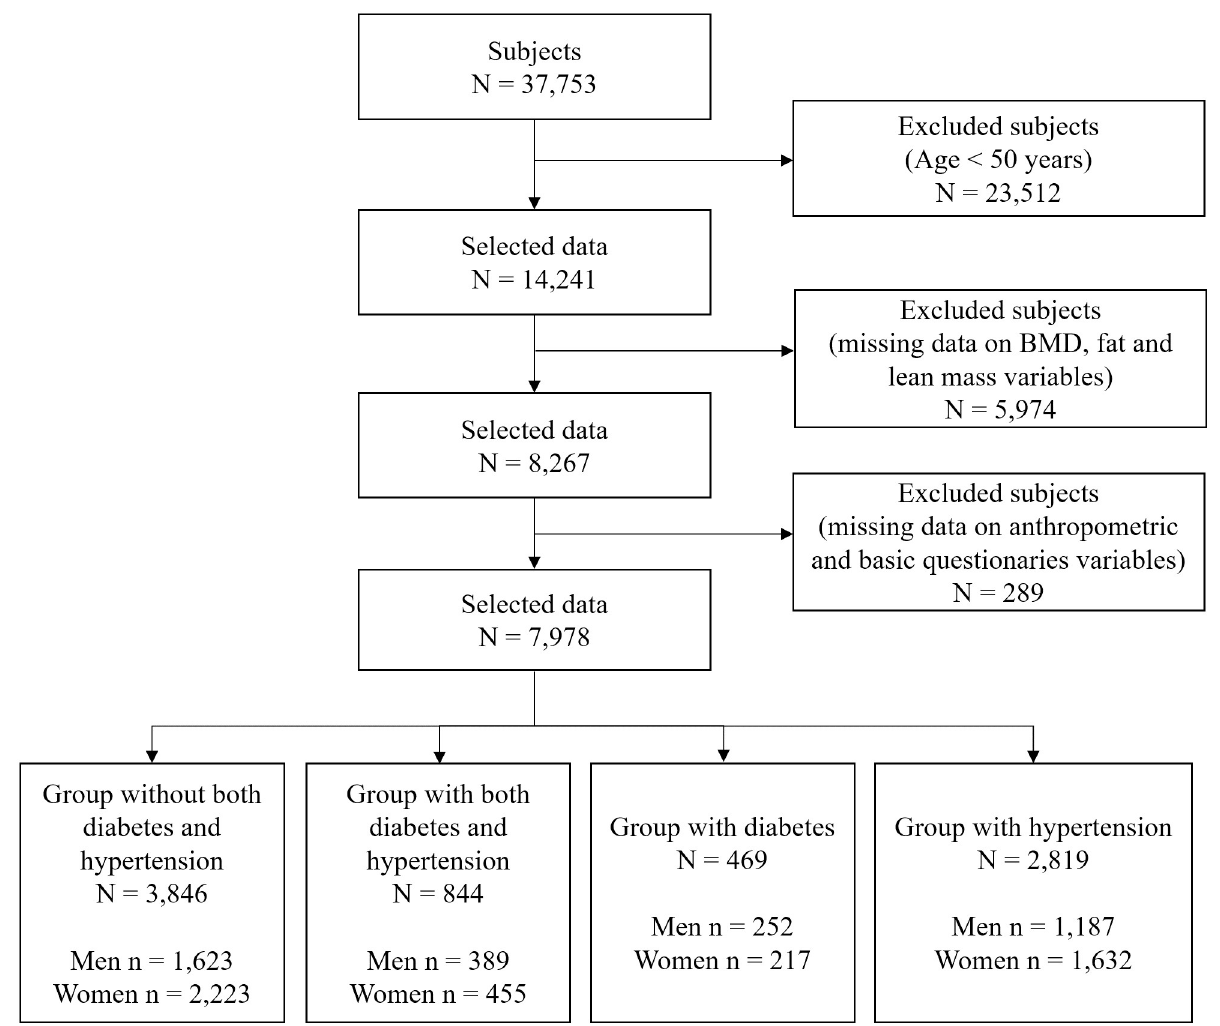
Fig 1. Sample selection procedure. BMD, bone mineral density.